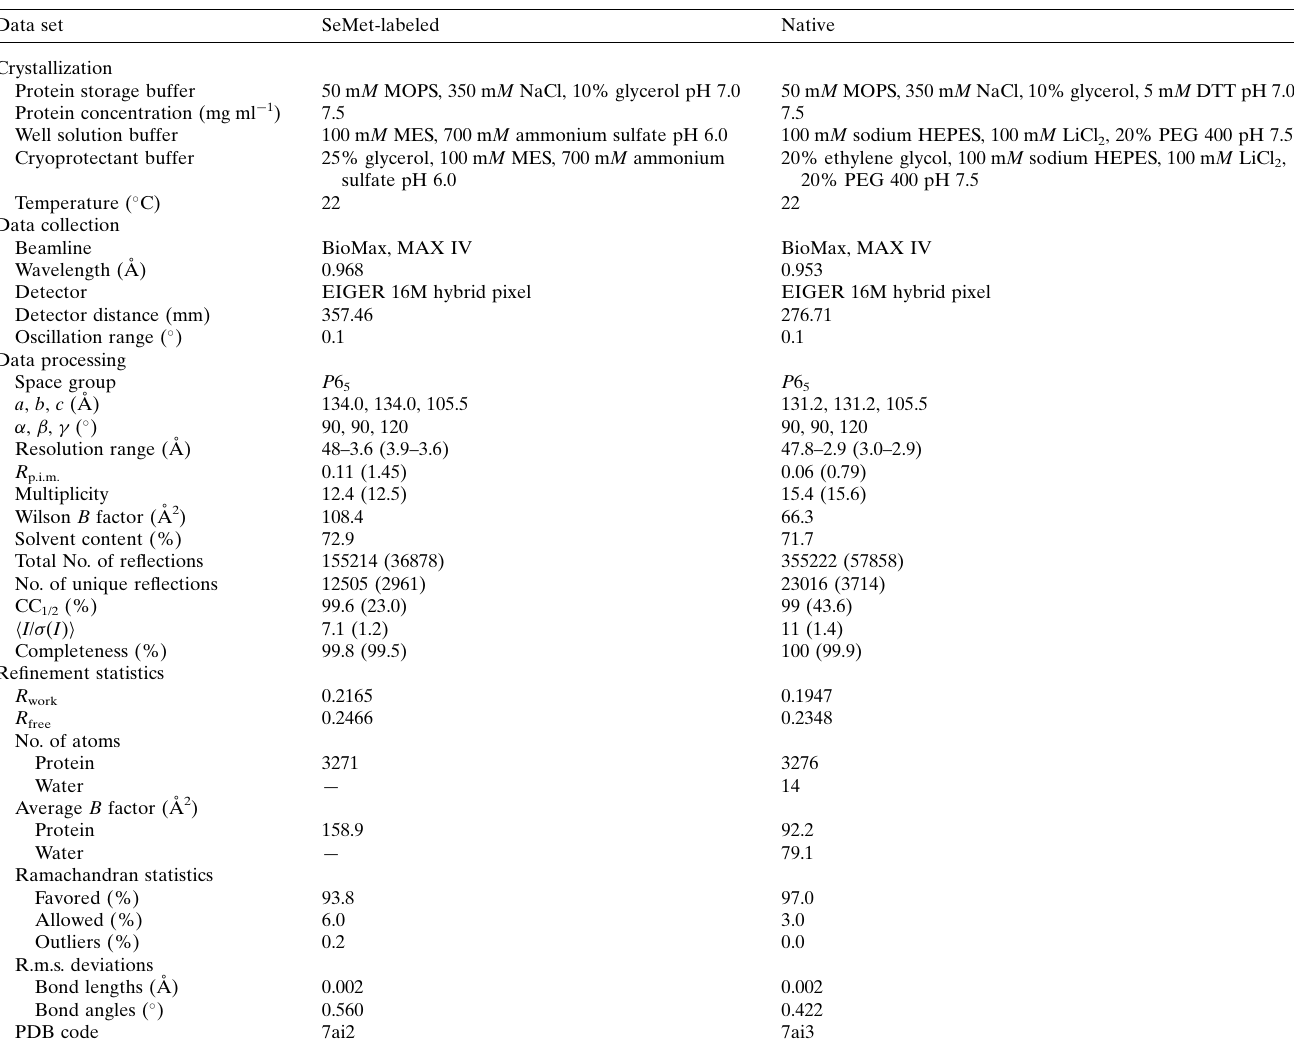
Table 1 Crystallization, data-collection and refinement statistics for the MtMce4A 39–140 structures. Values in parentheses are for the highest resolution